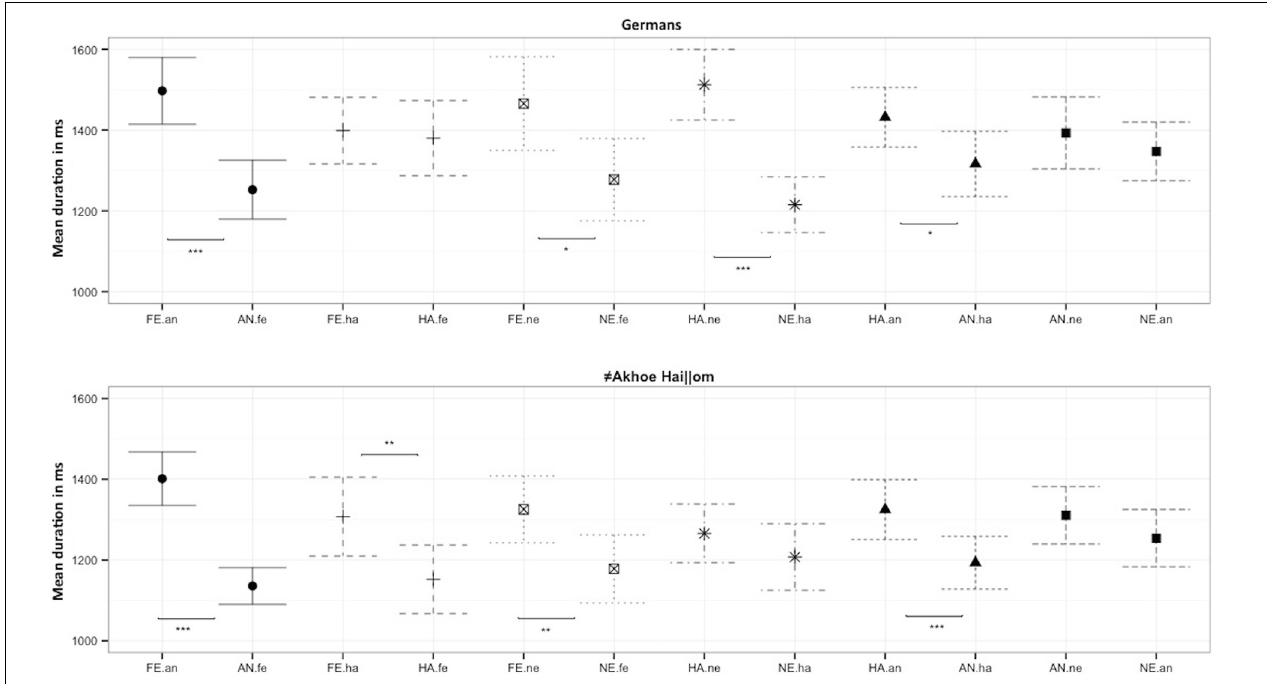
FIGURE 2 | Mean fixation duration for the comparison of a target emotion (in capital letters) vs. a distractor emotion (in lower case letters) for Germans and the (cid:54)= Akhoe Hai||om. fe, fear; an, anger; ha, happy; ne, neutral. Scales show the mean fixation duration in milliseconds. Significant differences are indicated by asterisks